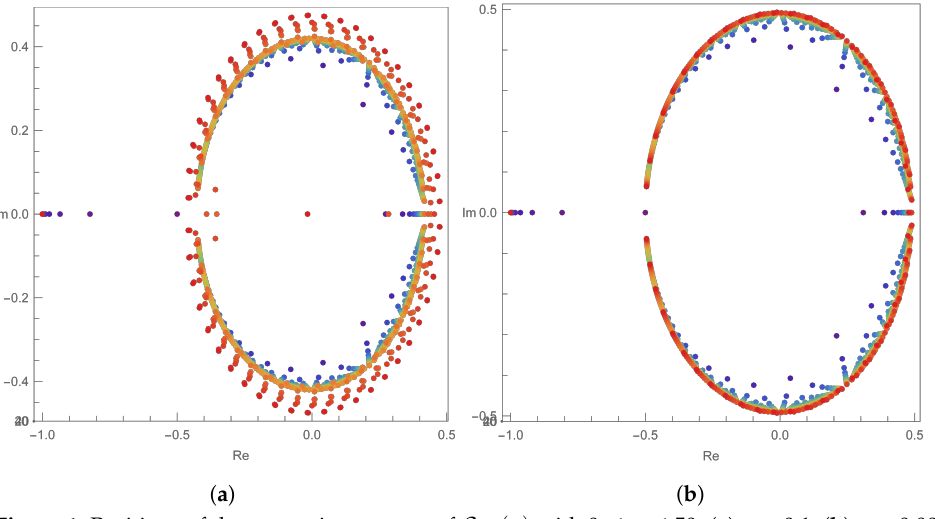
Figure 1. Positions of the approximate roots of S n , q ( x ) with 0 ≤ n ≤ 50: ( a ) q = 0.1, ( b ) q =